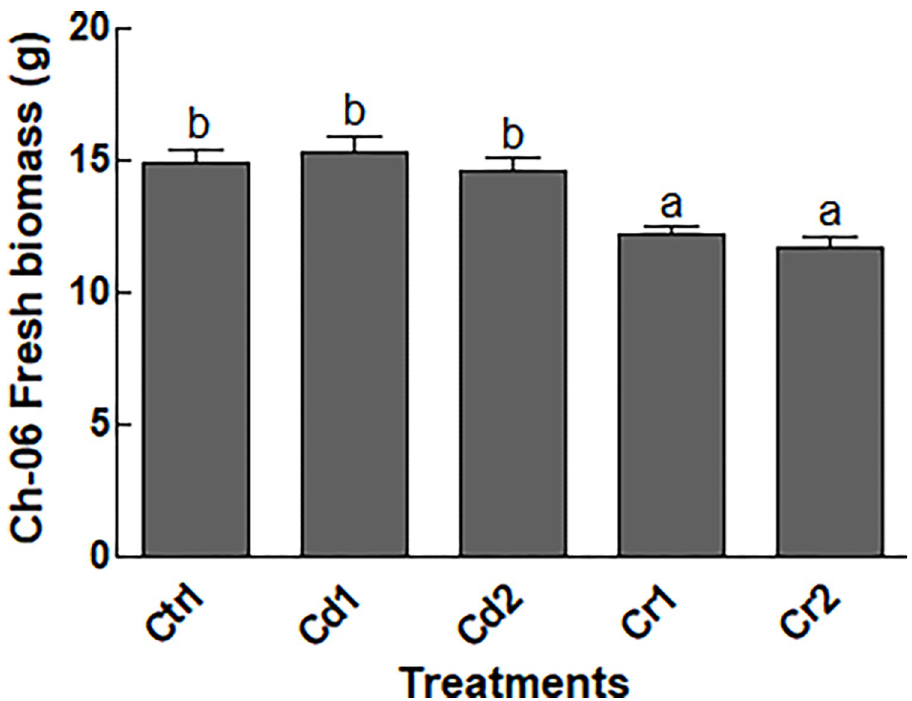
Fig 1. Impact of Cd and Cr stress on biomass Ch-06 fresh biomass. Ctrl = control, Cd = cadmium, Cr = chromium, Cd1 and Cr1 = 100 μ g/g, Cd2 and Cr2 = 500 μ g/g. The data reflect the mean of triplicated data followed by ± SE. The data with different superscript letter are significantly different at P =